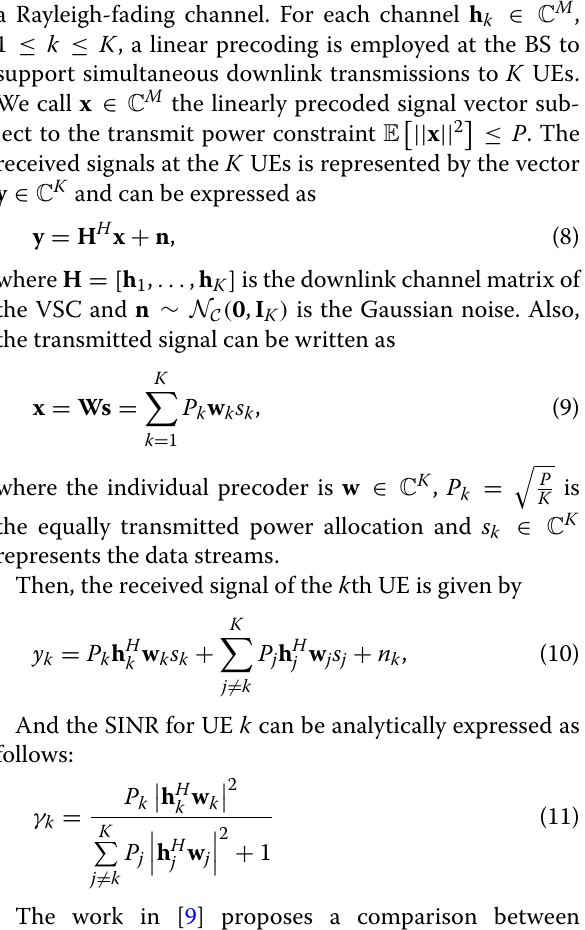
a Rayleigh-fading channel. For each channel h k ∈ C M , 1 ≤ k ≤ K , a linear precoding is employed at the BS to support simultaneous downlink transmissions to K